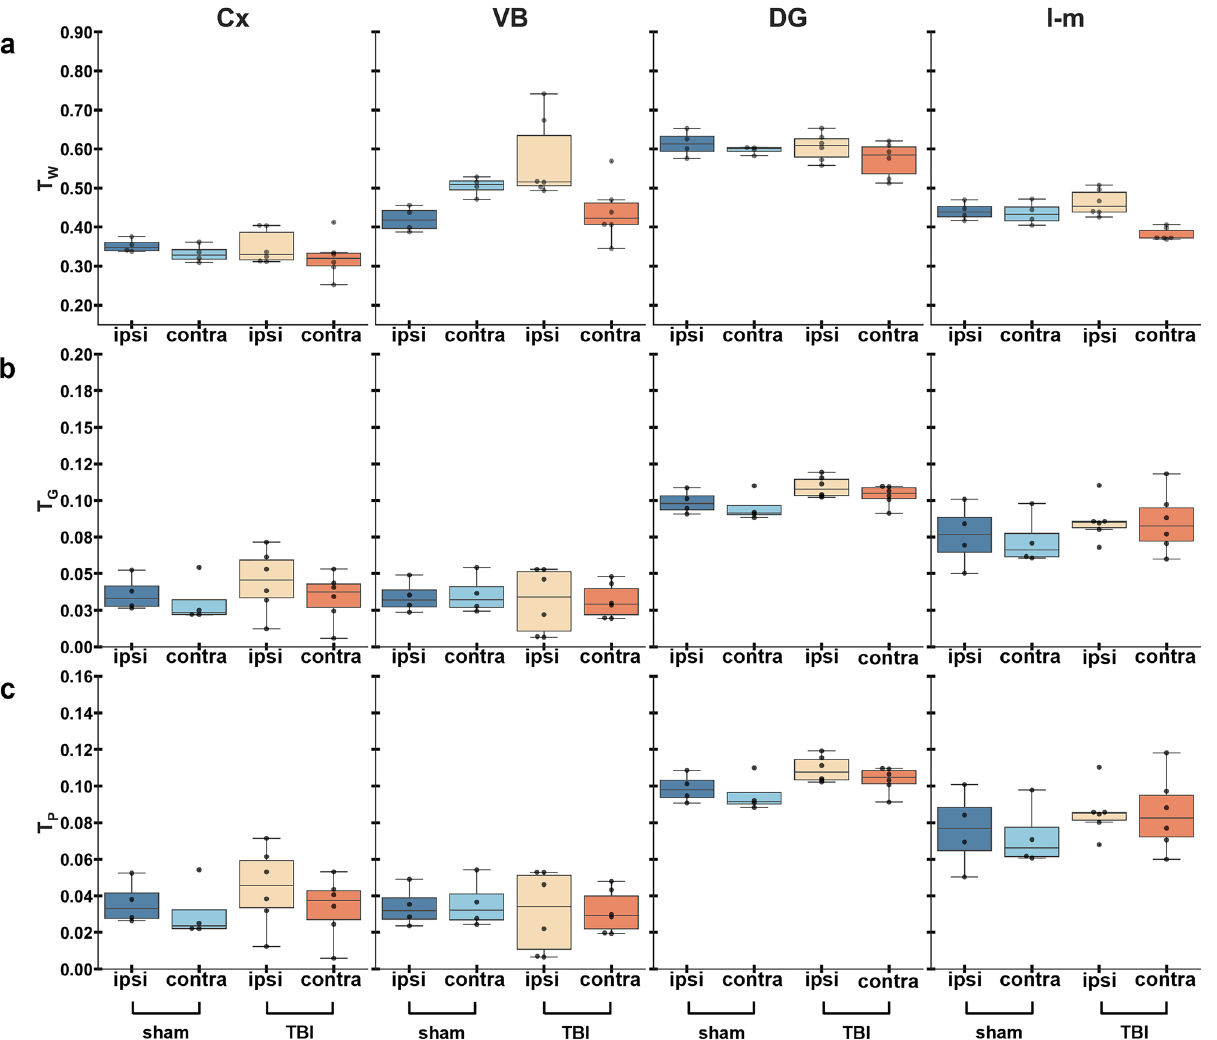
Figure 7. Relative three-tissue signal fractions in grey matter areas. Results are shown as minimum, lower quartile, median, upper quartile and maximum. Results of the compositional analysis are shown in Table 1. Abbreviations: Cx, perilesional cortex; DG, dentate gyrus; T W , T G , T P , signal fraction maps representative of white matter, grey matter, and PBS; l-m, stratum lacunosum-moleculare; VB, ventrobasal